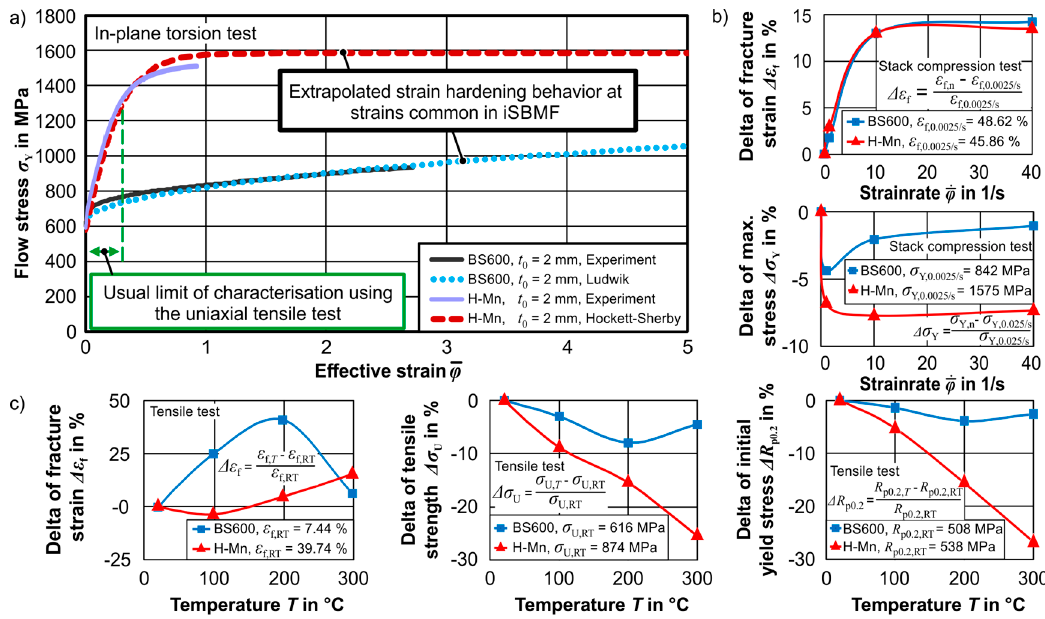
Figure 2. ( a ) Flow curves of the investigated materials and their extrapolation with different approaches (in-plane torsion test at room temperature), ( b ) influence of increased strain rates (stack compression tests at room temperature) and ( c ) increased temperatures (hot tensile tests, in rolling direction) on the material behavior ( t 0 = 2 mm).